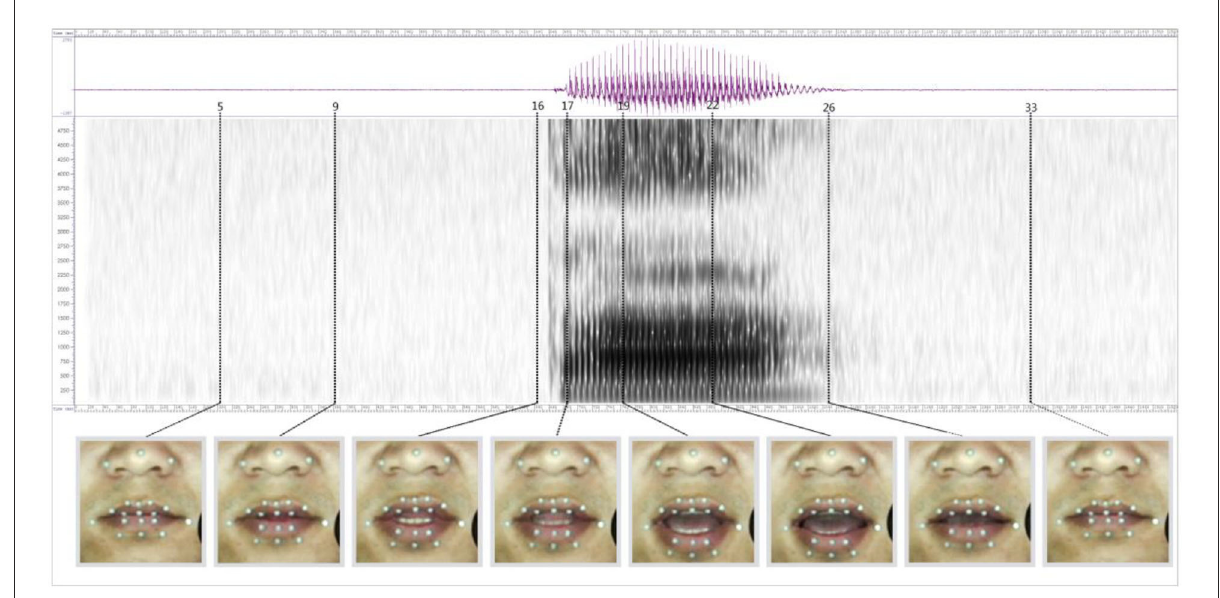
FIGURE7 The sonogram, spectrogram, and lip shape viseme of the target position of the Tibetan “ ”.